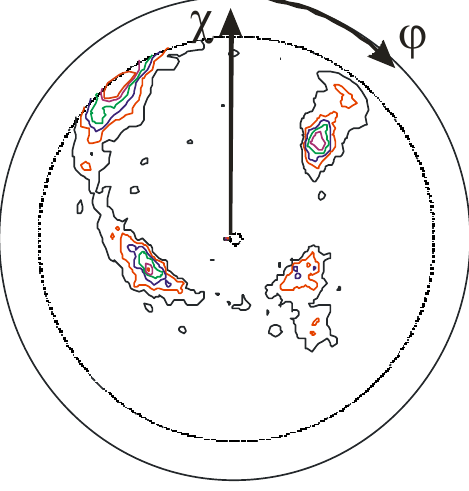
Figure 12 . {111} TiN pole figure indicating a medium to weak biaxial texture with the (200) orientation tilted by about 20–30° from the surface normal, as seen in the shift of the center of the ring-like structure towards χ = 20–30° and the formation of four, more or less pronounced pole density maxima inside the ring structure, in contrast to Figure